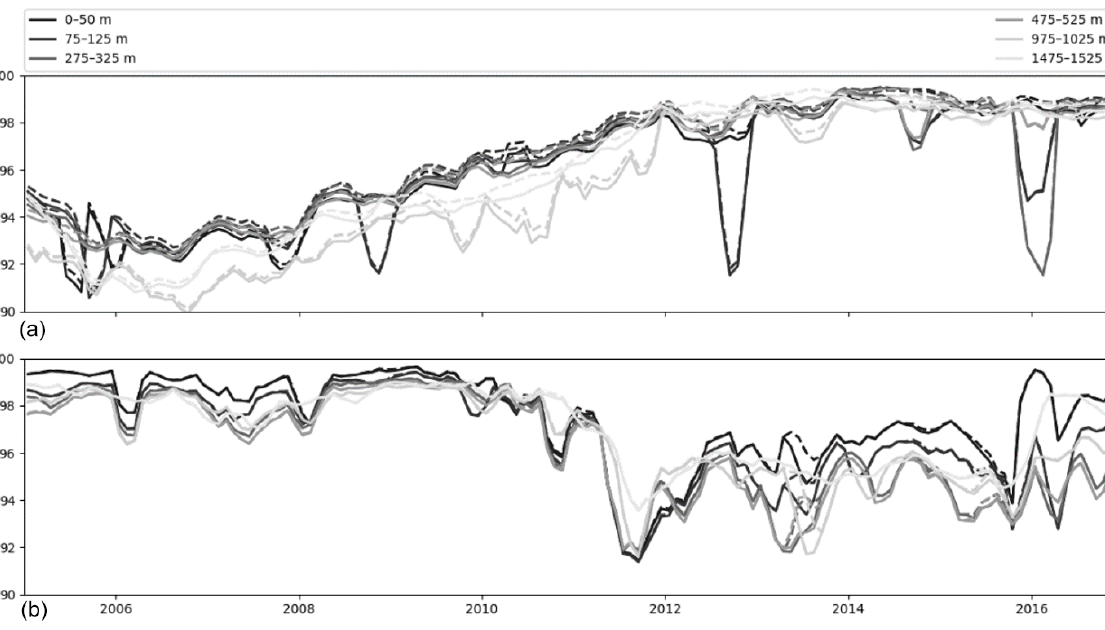
Figure 6. Percentage of good flags (flags 1 and 2) in the analyzed layers for the NRT dataset (solid line) and for the CORA dataset (dashed line): (a) temperature, (b)